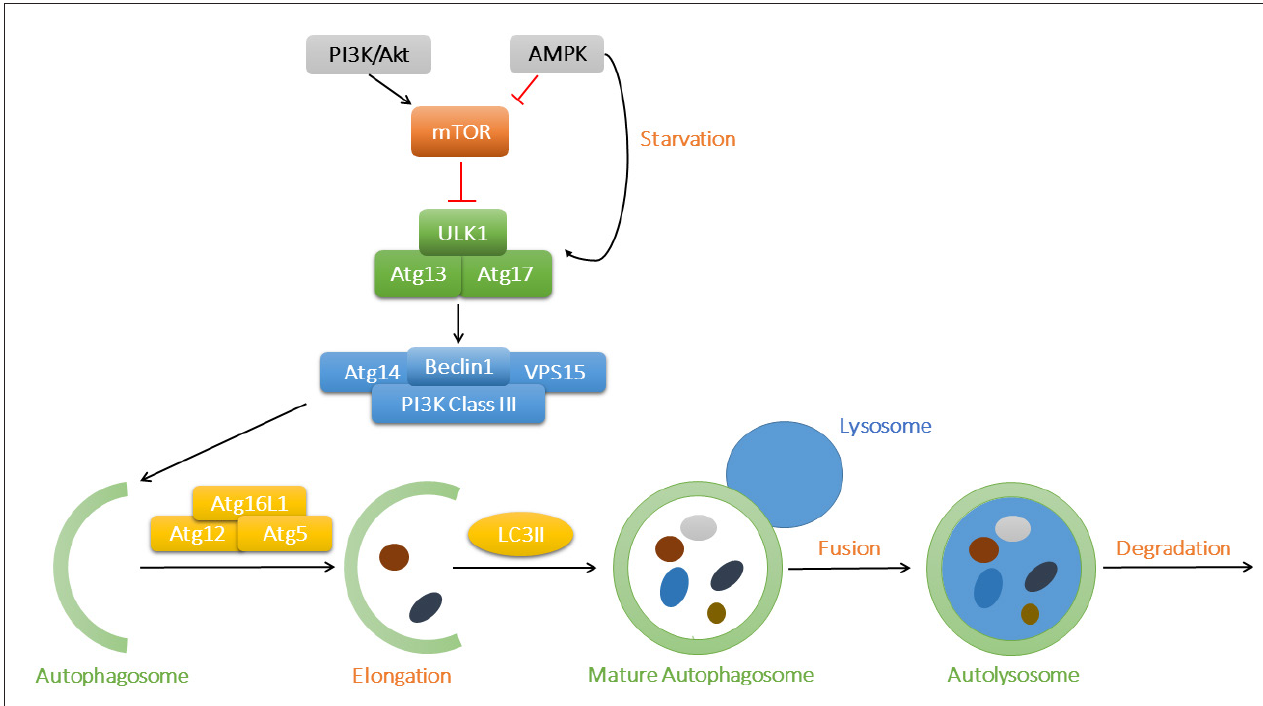
FiguRe 1 | The process of macroautophagy and its main signaling regulatory mechanisms. The key regulator mTOR binds to ULK1 to suppress its activation, while AMPK and PI3K/Akt act as the primary upstream signaling regulatory molecules for mTOR. AMPK might be activated in starvation to promote the initiation of autophagy. ULK1 complex then activates Beclin1 complex and contributes to autophagosome nucleation. Atg12, Atg5 and Atg16L1 complex is involved in the elongation of autophagosome membrane, with LC3II being recruited into expanding cargos. Finally, mature autophagosomes fuse with lysosomes and